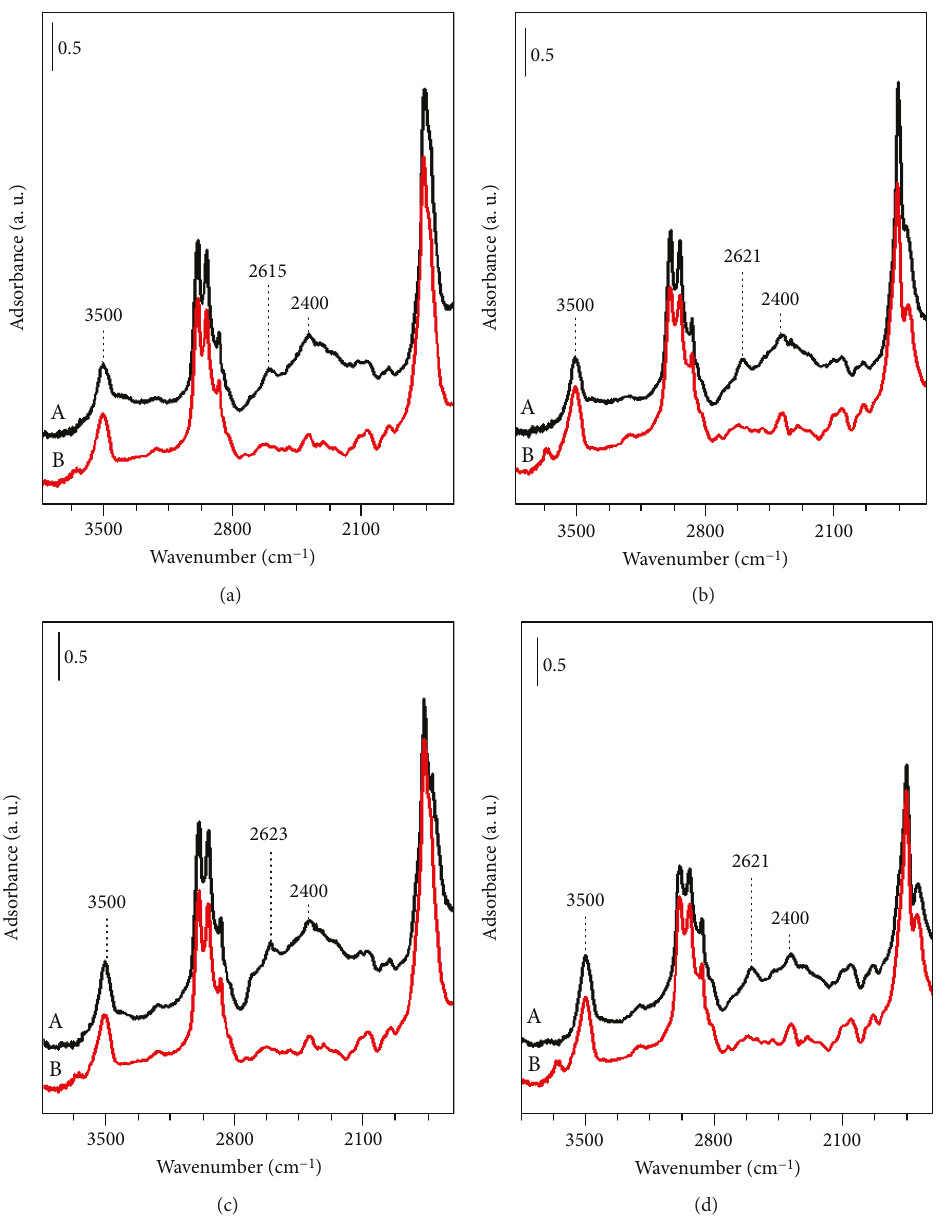
Figure 4: DR-FTIR spectra in the range 3700 – 1600cm − 1 of (a) spectra of samples in vacuum; (b) spectra of samples in vacuum after the interaction with D O 2 (g)